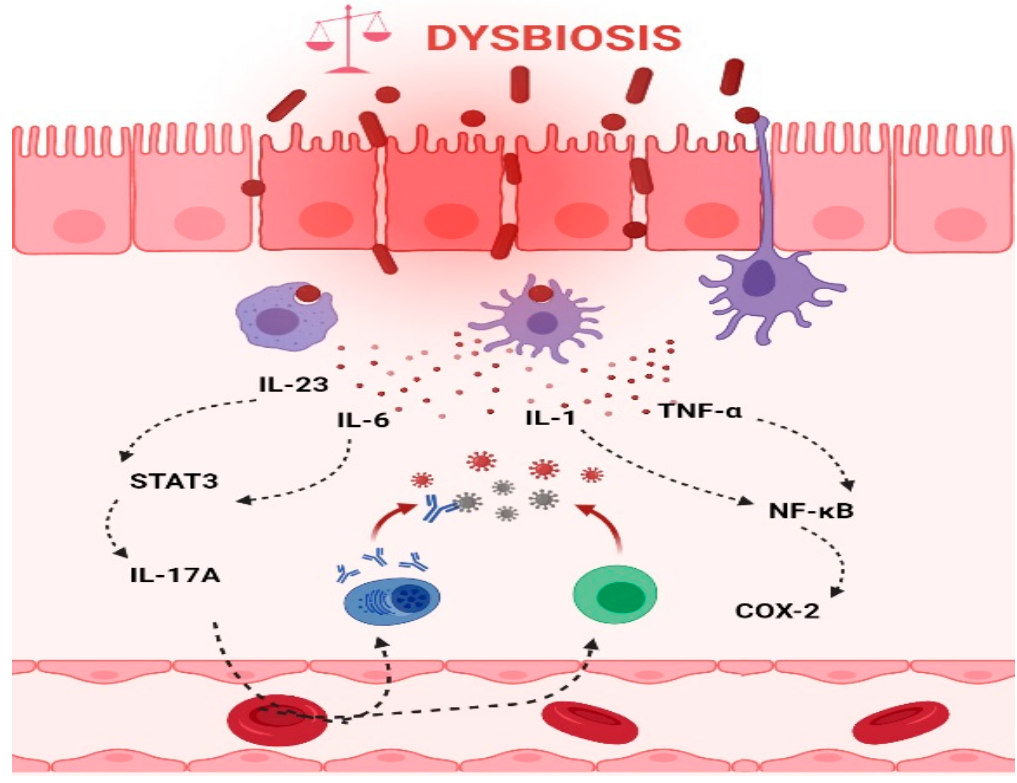
Figure 3. Intestinal inflammation caused by gut microbiota contributes to the onset of CRC. Dysbiotic bacteria can elicit immune imbalances and facilitate the translocation of gut microbiota and/or its metabolites due to a leaky gut to the tissues and systemic circulation. These events may lead to the stimulation of an inflammatory state and ultimately to the development of CRC. Thus, the production of IL-6 and IL-23, in turn, trigger the expression of IL-17A and contribute to the development of CRC through STAT3 activation. In addition, TNF- α and IL-1 promote pro-inflammatory and pro-tumorigenic activities of COX-2 that stimulate growth and angiogenesis and inhibit apoptosis in CRC. (The figure was created with Biorender.com).